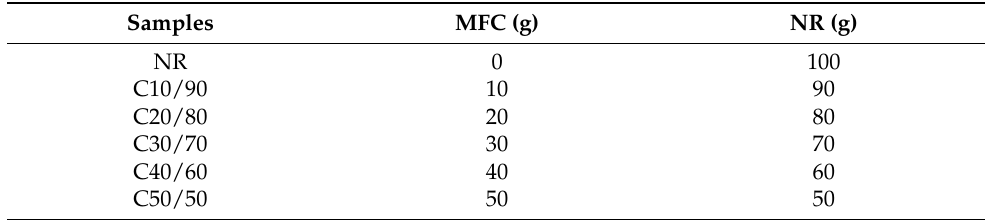
Table 1. The composition of microfibrillated cellulose–natural rubber (MFC–NR) composite films.